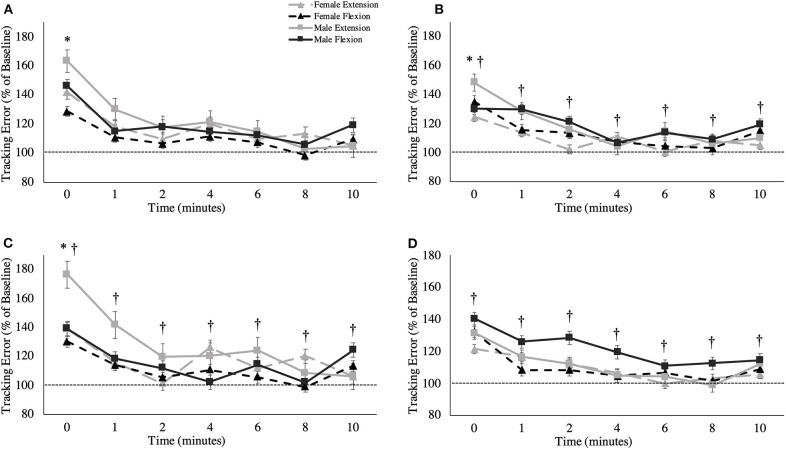
Tracking error (percentage of baseline) across recovery time points for specific movement directions: (A) ulnar deviation, (B) radial deviation, (C) extension movement, and (D) flexion. The dashed line represents baseline tracking error. This metric is presented as group averages (with standard error bars). The data is separated by sex and muscle group. † = data are significantly different between sexes; * = pooled data are significantly different from baseline.